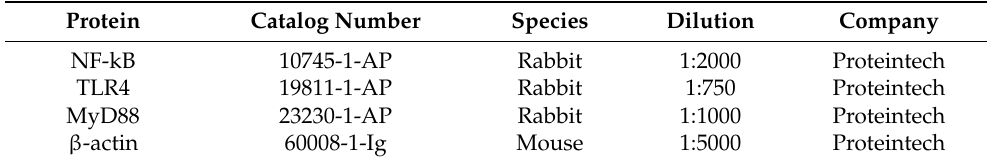
Table 4. Antibodies applied for current research. Protein Catalog